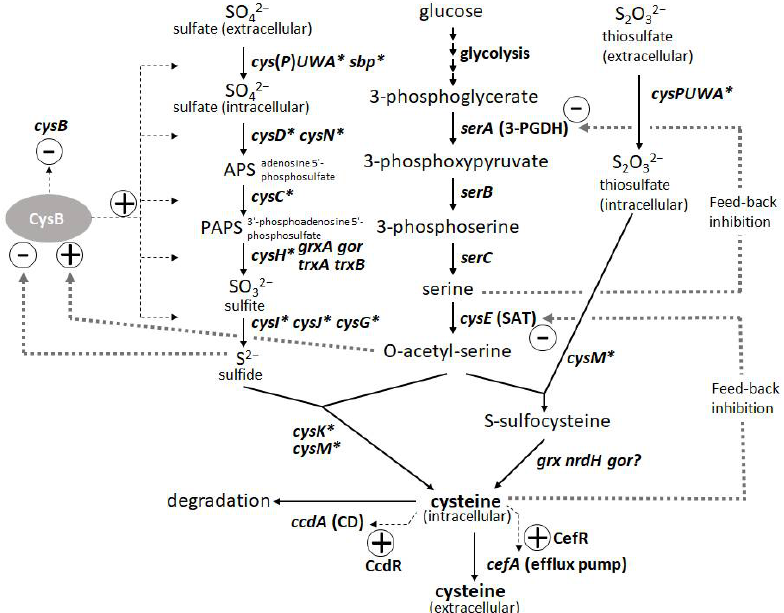
Figure 3. Biosynthetic pathway and regulation of L-cysteine in Pantoea ananatis AJ13355 [45]. Thin and thick dotted lines indicate transcription and protein regulation, respectively. Asterisk indicates CysB regulon.